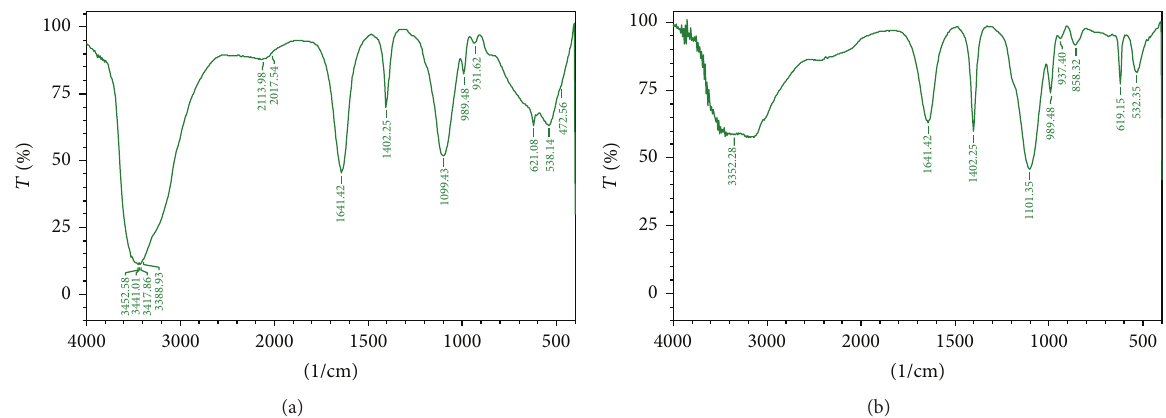
Figure 3: FTIR spectrum of toluene before and after degradation. About 1% toluene incubated with VITRSB1 strain for 48 hrs and analysed in FTIR. (a) Toluene before degradation with VITRSB1 strain. (b) Toluene after degradation with VITRSB1 strain.